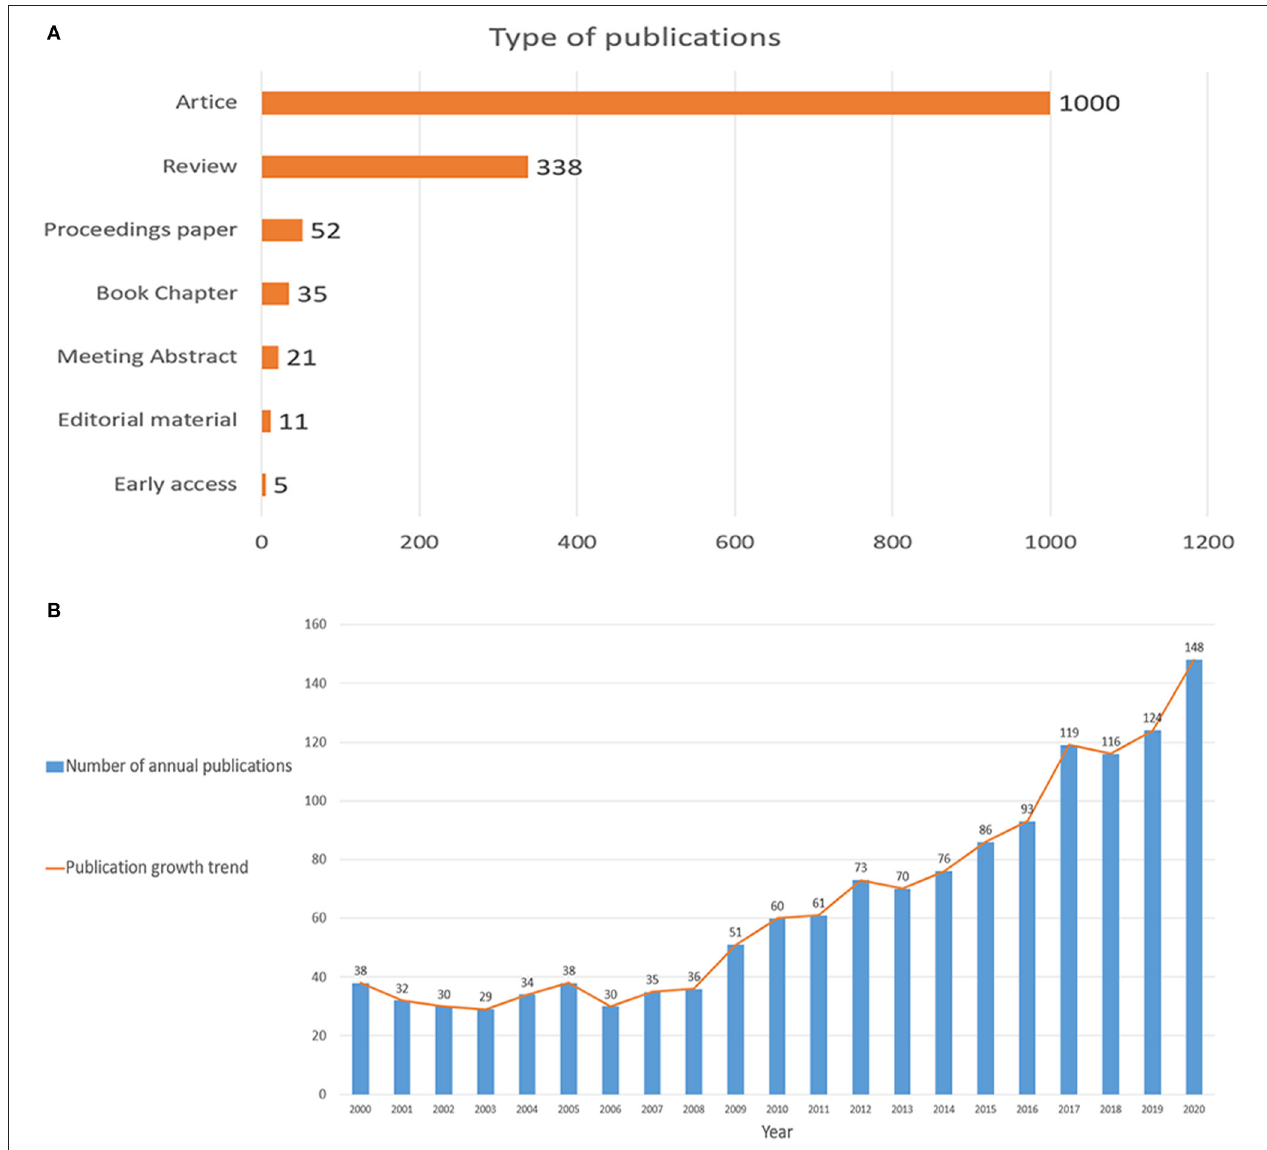
FIGURE 1 | (A) Types of publications; (B) The combination chart of the number of annual